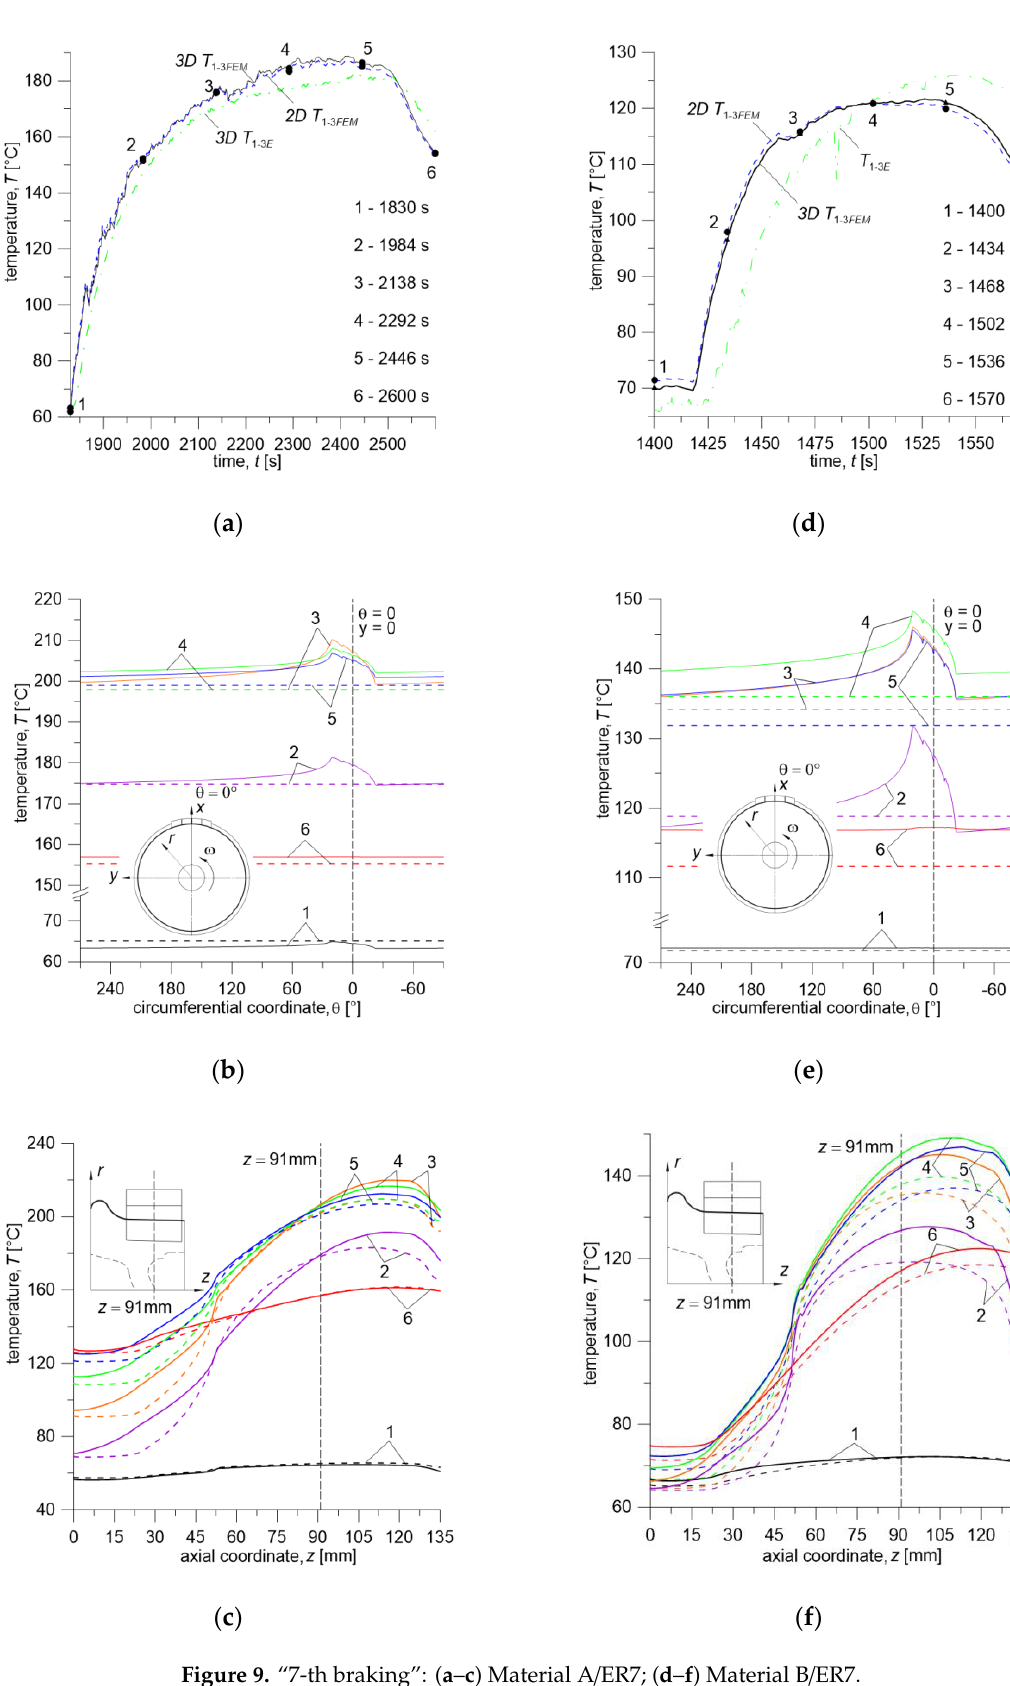
Figure 9. “7-th braking”: ( a – c ) Material A/ER7; ( d – f ) Material B/ER7.